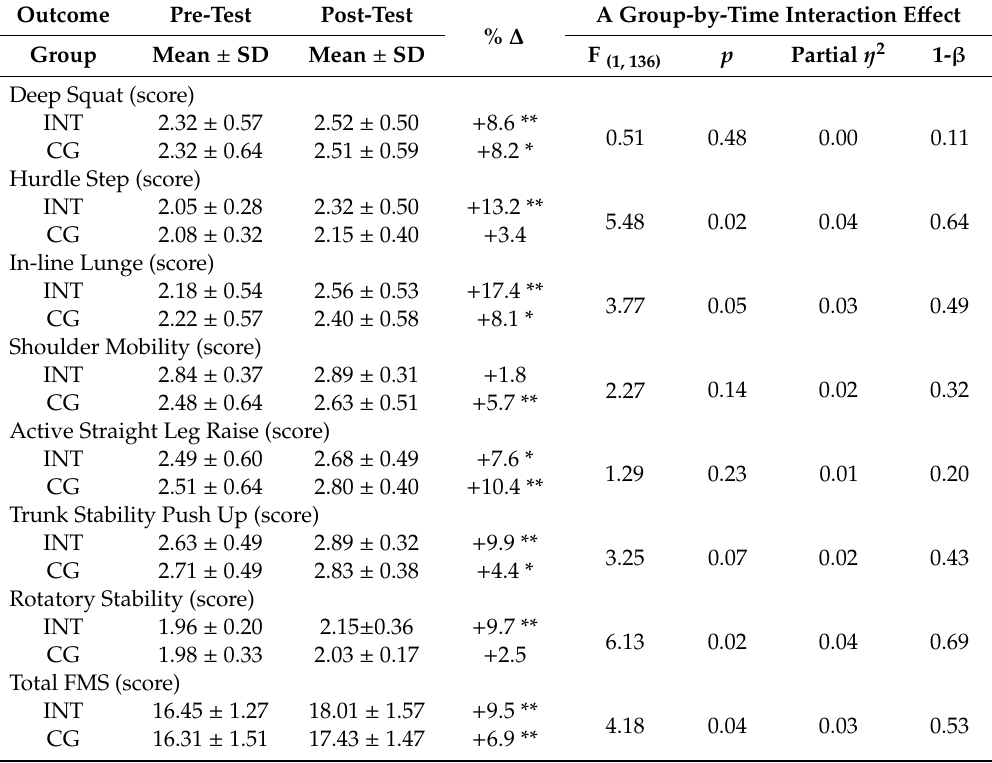
Table 2. The Functional Movement Screen (FMS) scores at pre- and post-test for the intervention and control